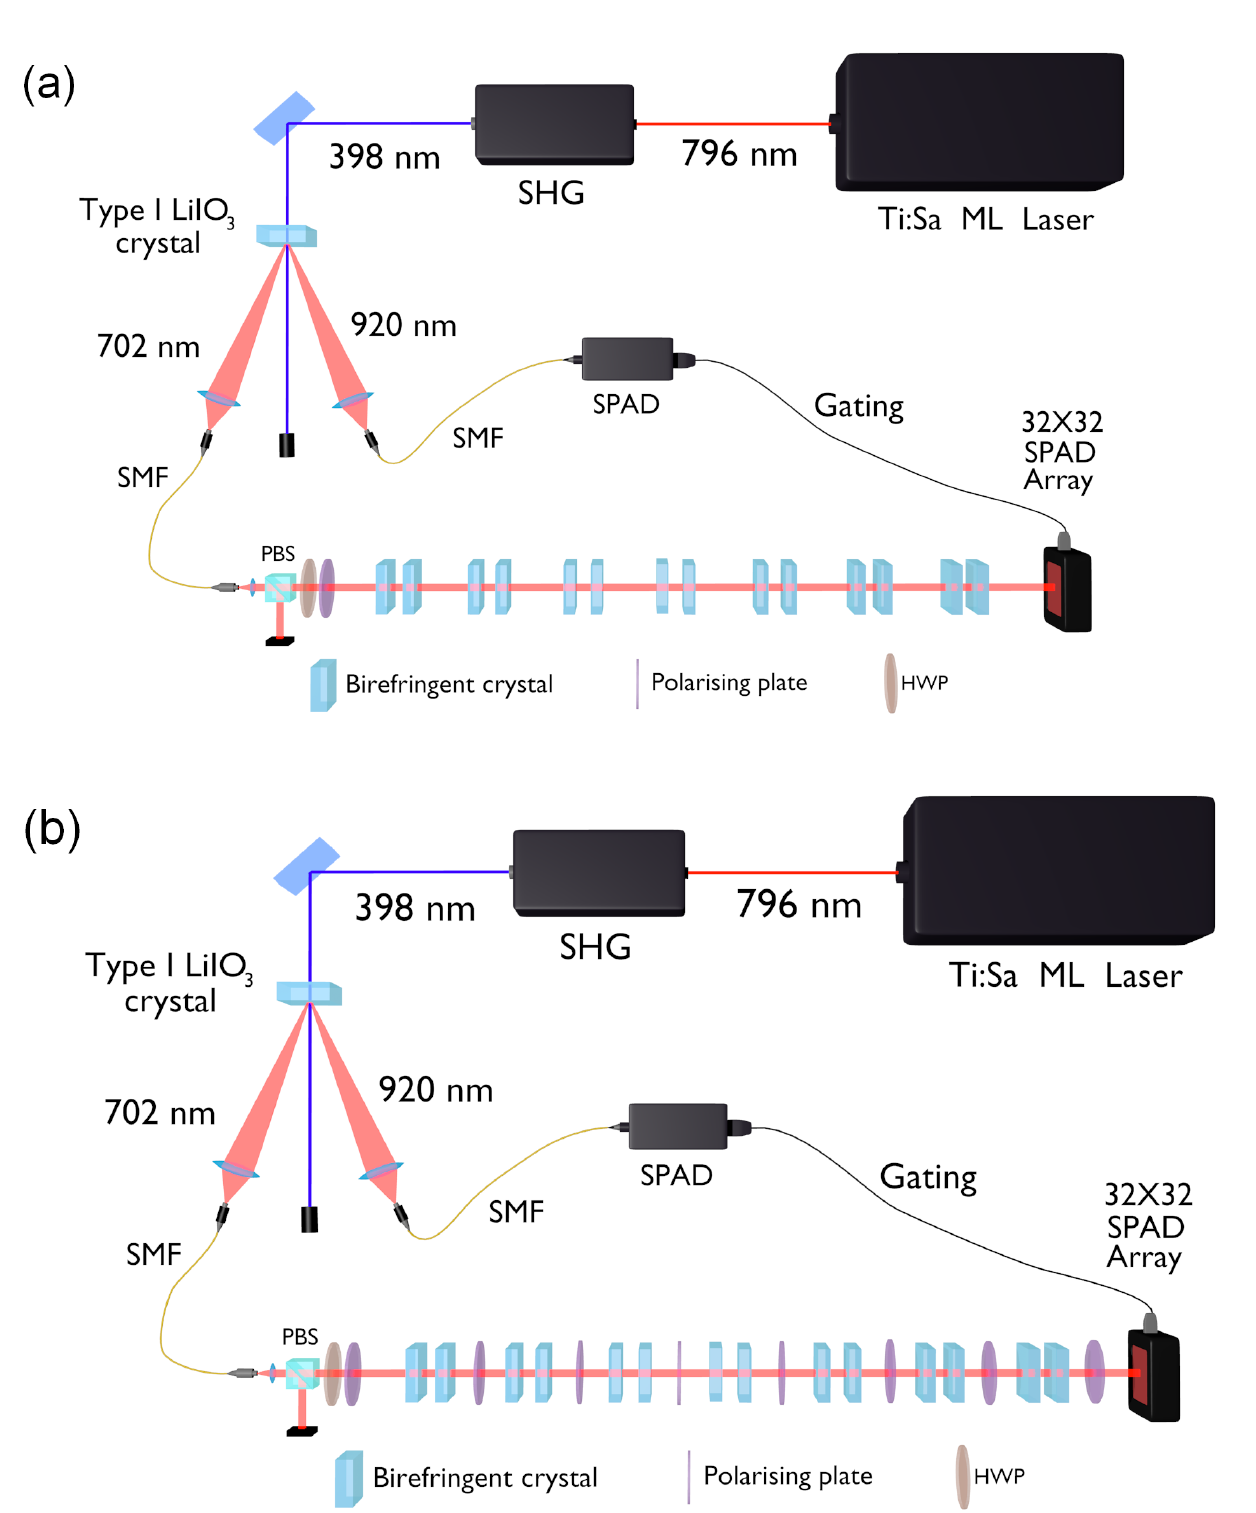
Figure 2. Experimental setups for projective measurement ( a ), extracting the expectation value of an observable by measuring an ensemble of identical particles, and protective measurement ( b ), able to reliably estimate such an expectation value with just a single detection event. Ti:Sa ML laser: titanium–sapphire mode-locked laser; SHG: second harmonic generator; SMF: single-mode fiber; SPAD: single-photon avalanche diode; PBS: polarizing beam splitter; HWP: half- wave